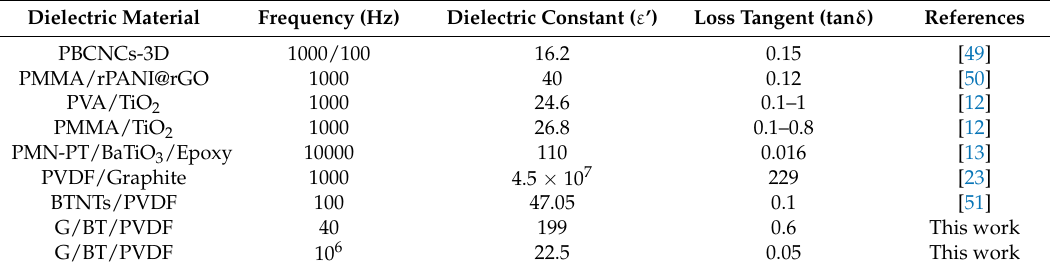
Table 2. Comparison of dielectric constant ( ε ’) and loss tangent (tan δ ) of G/BT/PVDF nanocomposite film with previously reported dielectric